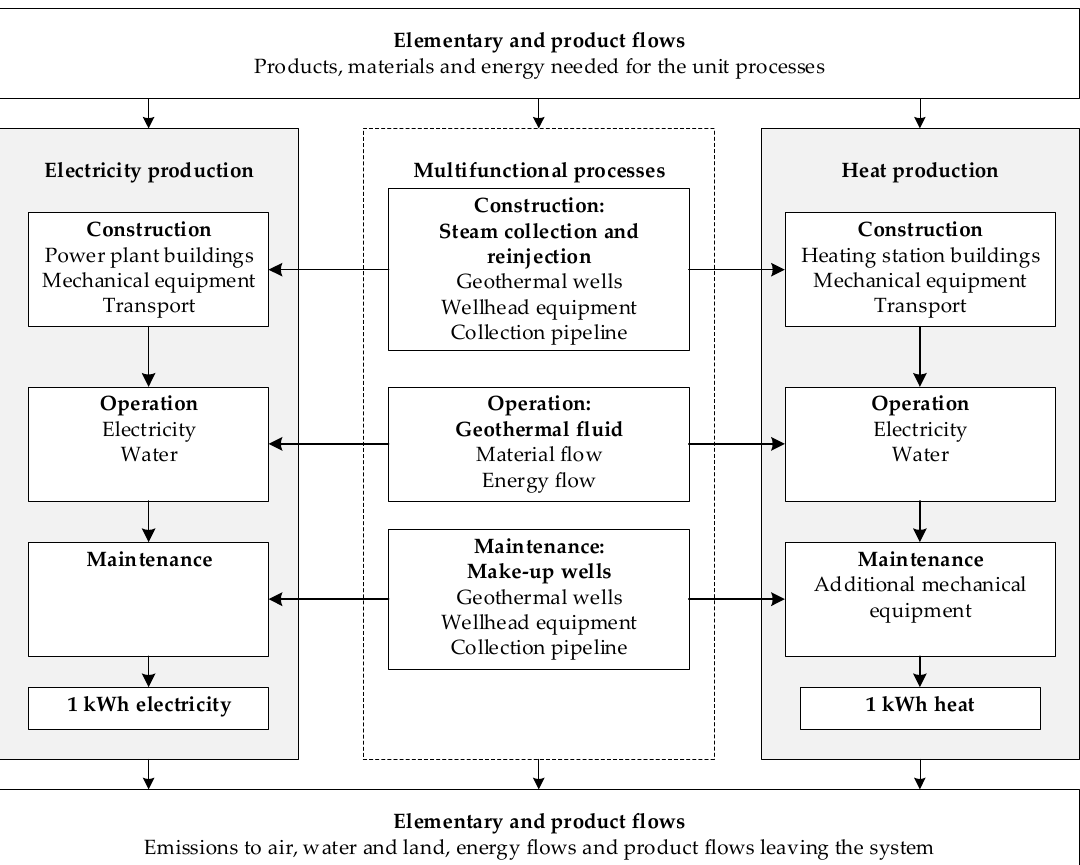
Figure 3. The main unit processes set up to describe the production of electricity and heat from the Hellisheidi geothermal CHP plant.